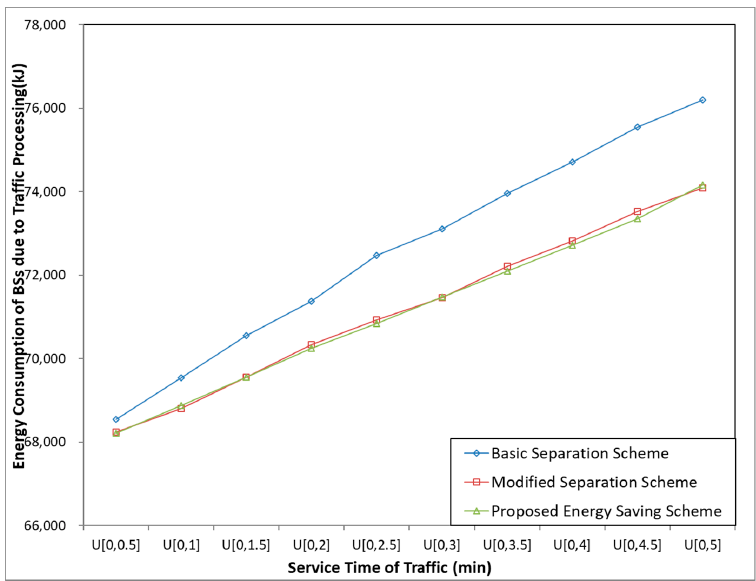
Figure 17. Energy consumption of BSs due to traffic processing.